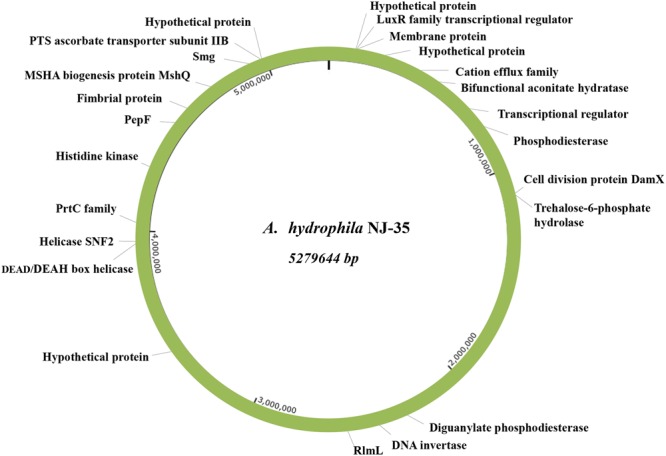
Relative positions of the identified biofilm-associated genes on the A. hydrophila NJ-35 genome map. Both the biofilm-increased and biofilm-deficient genes are displayed in this map, showing that the EZ-Tn5 transposon was randomly inserted into the genome.